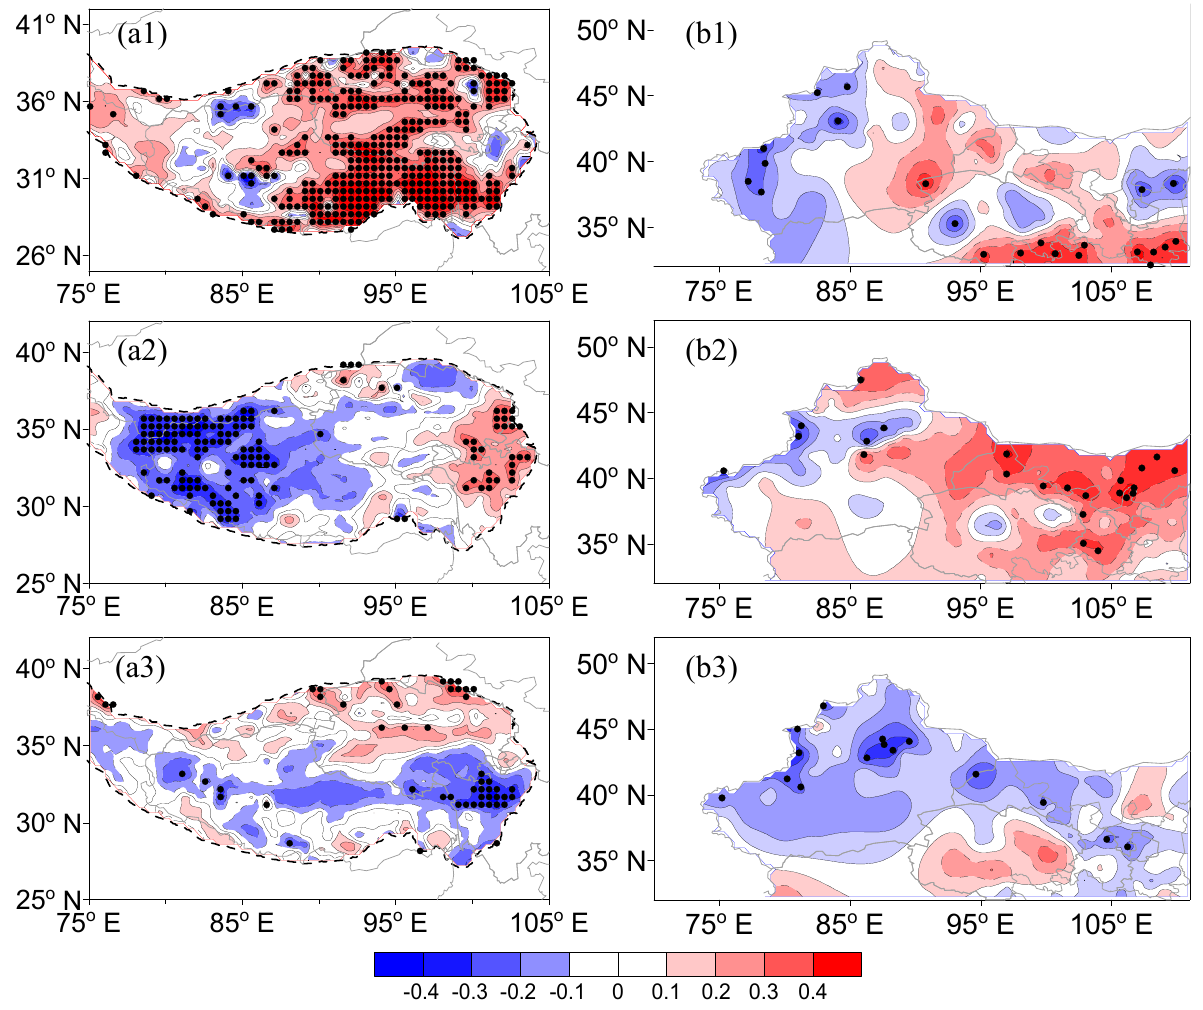
Figure 5. The spatial distributions of the correlation coefficients of the first three SVD modes of the spring snowmelt over the TP and summer precipitation in Northwest China (from top to bottom: SVD1, SVD2 and SVD3): ( a ) the TP spring snowmelt field; ( b ) the summer precipitation field in NWC. The black spot areas passed the 95% significance test.